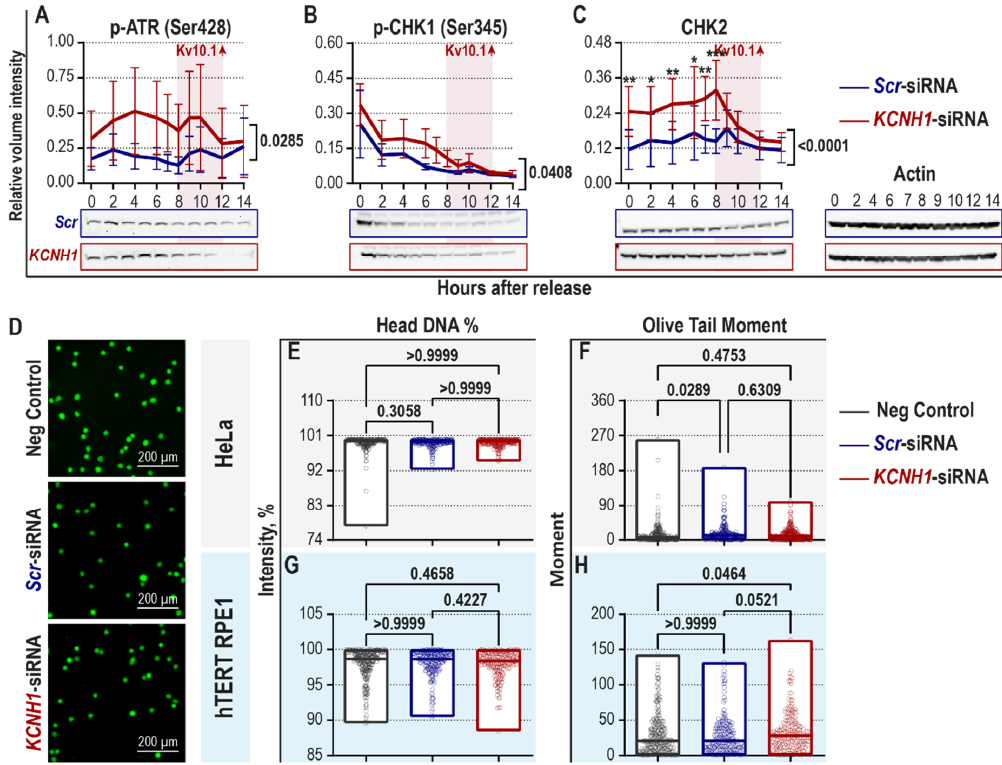
Figure 1. Kv10.1 downregulation activates the DNA damage-induced checkpoint in the absence of DNA damage in HeLa cells. ( A – C ) Hela cells were transiently transfected with either Scr - or KCNH1 - siRNA, synchronized with double thymidine block at the G1/S border, and subsequently released from the block. Samples were collected at the indicated time-points after release from the block. Representative immunoblots and the results of densitometry analysis are plotted. The time interval corresponding to Kv10.1 expression is indicated in pink ( n = 3 independent experiments; mean ± SEM; two-way ANOVA, repeated measures, Bonferroni post hoc test; the exact p -values indicate the significance of the global difference between the groups, and the p -value between single time points is indicated by asterisks: * p < 0.05, ** p < 0.01, *** p < 0.001). ( D – H ) HeLa and hTERT RPE1 cells were transiently transfected with either Scr - or KCNH1 -siRNA, allowed to reach 70% confluency, harvested, and immediately used for single-cell gel electrophoresis (comet assay). ( D ) Representative images of the DNA comets stained with SYBR-Gold are given (max intensity projection, z-step, 0.2 µ m, scale bar, 200 µ m). ( E – H ) The comets were analyzed with the CASPLab software and Head DNA % and Olive Tail Moment are plotted in ( E , F ) for HeLa cells, and in ( G , H ) for hTERT RPE1 cells ( n = 5 independent experiments with > 750 comets per condition; Kruskal–Wallis test with Dunn’s post hoc test, min to max range with the median indicated as a line are shown, with p -values indicated for each pair). (Kv10.1—potassium